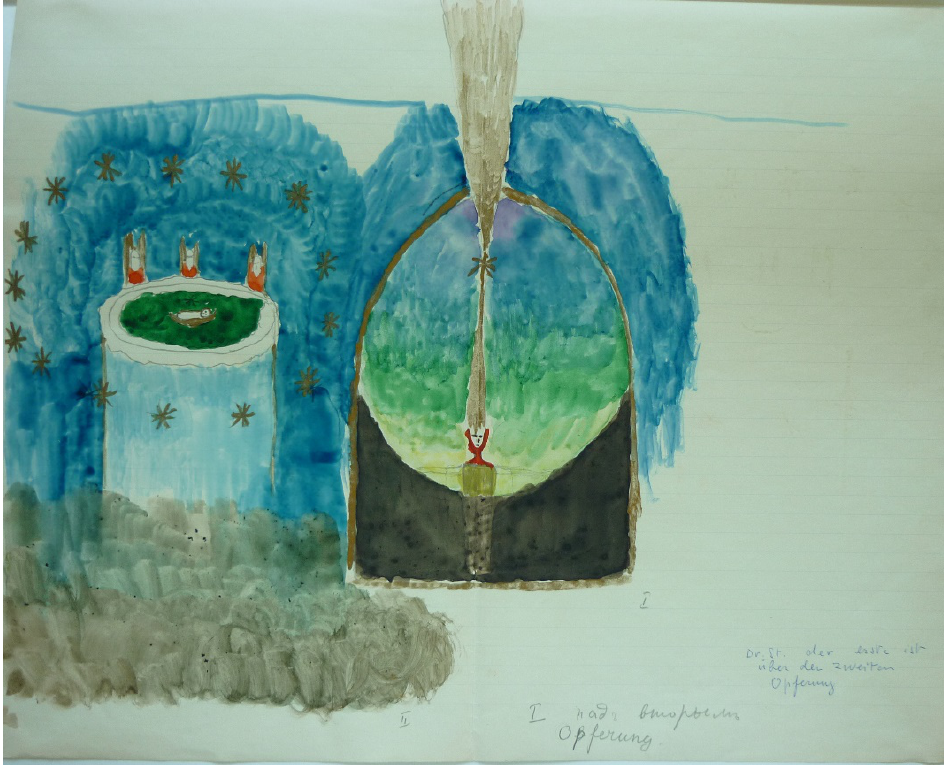
Figure 13. Bely’s drawing. 1913? Rudolf Steiner Nachlassverwaltung (Dornach).